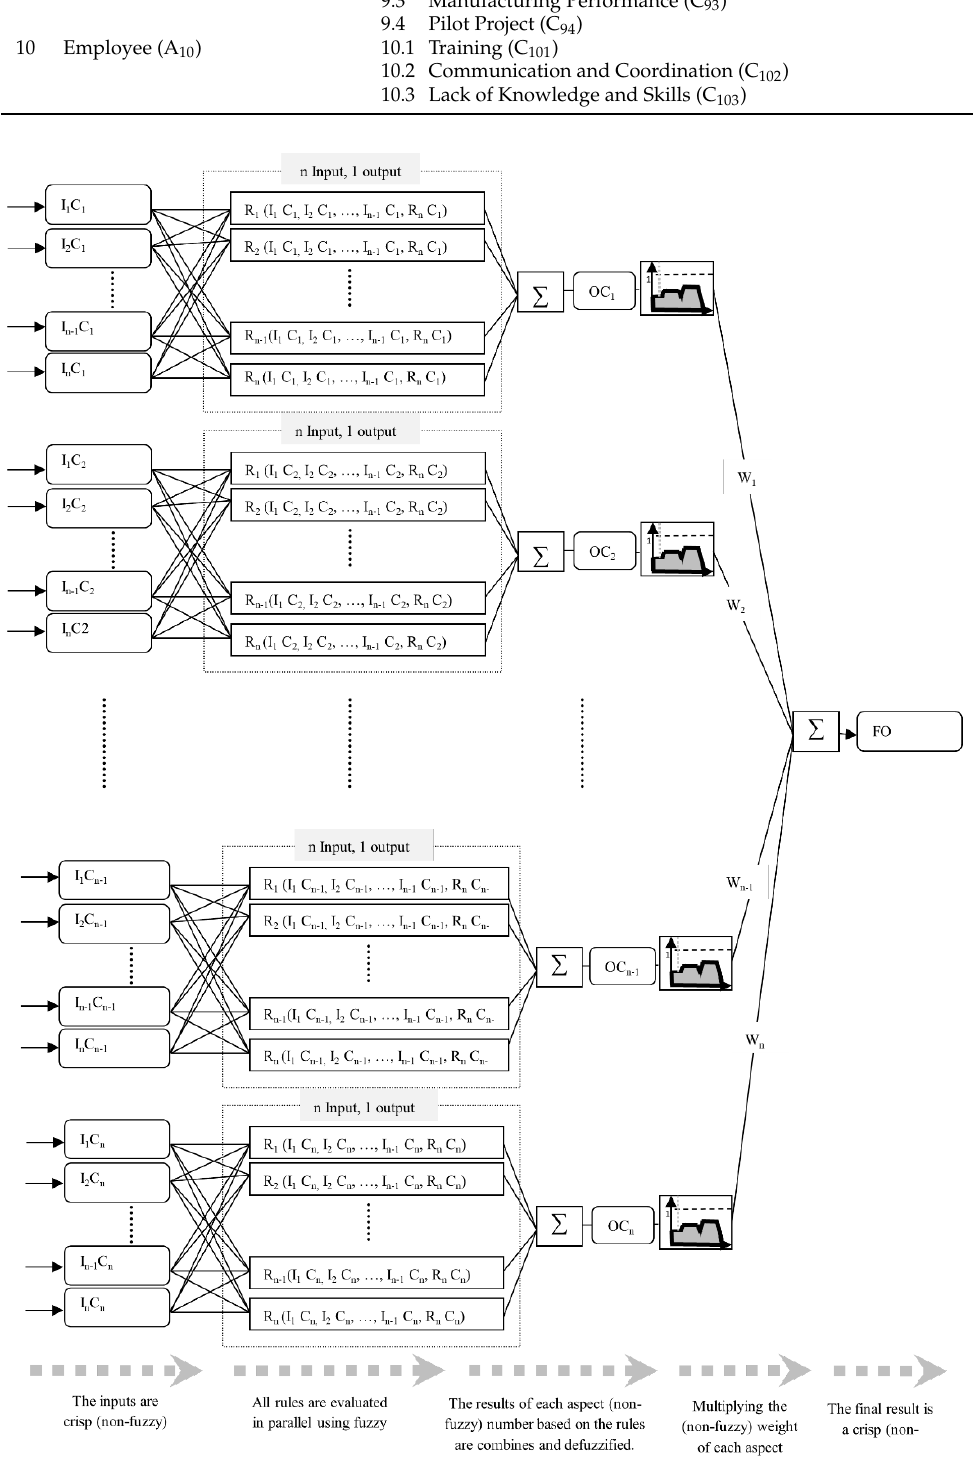
Figure 6. The hierarchical model of success for predicting implementation technology. Three decision-makers called D 1 , D 2 , and D 3 use the weights to assess each aspect. A total of ten aspects are considered, namely, strategy (A 1 ), financial (A 2 ), organization/busi- ness (A 3 ), support (A 4 ), technical (A 5 ), management (A 6 ), vendor/supplier (A 7 ), pro- cess/planning (A 8 ), project champion (A 9 ), and employee (A 10 ). The membership functions and the linguistic variables for the importance weights of criteria are summarized in Fig- ure 4 and Table 2, respectively. FDM is used to adjust the fuzzy weights of each expert in order to reach a consensus condition. The importance weights of all criteria for the three decision-makers are shown in Table 7.